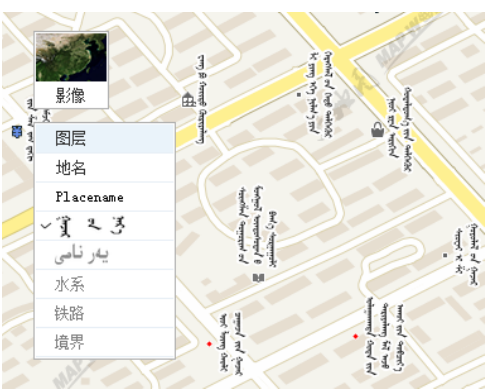
Figure 5. Switch Among Different Languages